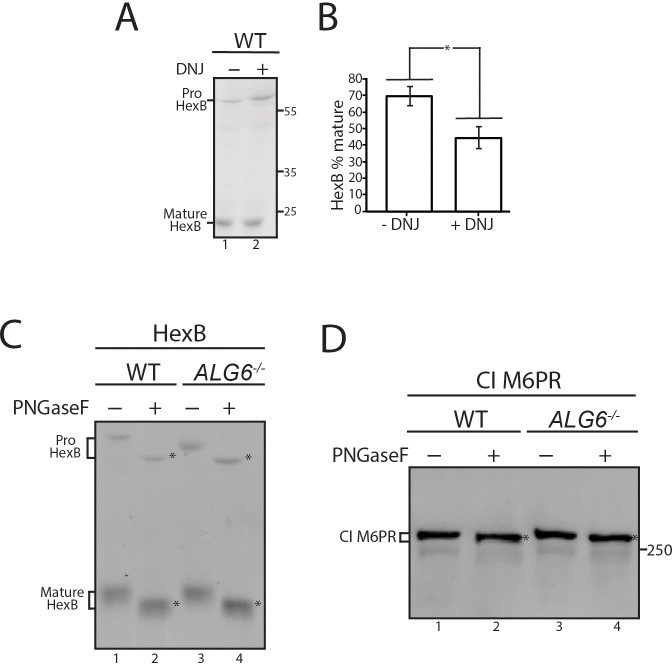
β-hexosaminidase subunit β trafficking and hypoglycosylation and CI-M6PR hypoglycosylation.(A) Cells treated without or with deoxynojirimycin for 12 hr, lysed and whole cell lysate samples were resolved and imaged by immunoblotting against β-hexosaminidase subunit β. Data is representative of three independent experiments and quantification is shown in (B). (C) The indicated cell lines were lysed and samples were split evenly between non-treated and PNGaseF treated. Asterisks denote deglycosylated protein (D). As described for panel C, except immunoblotting was against CI M6PR.